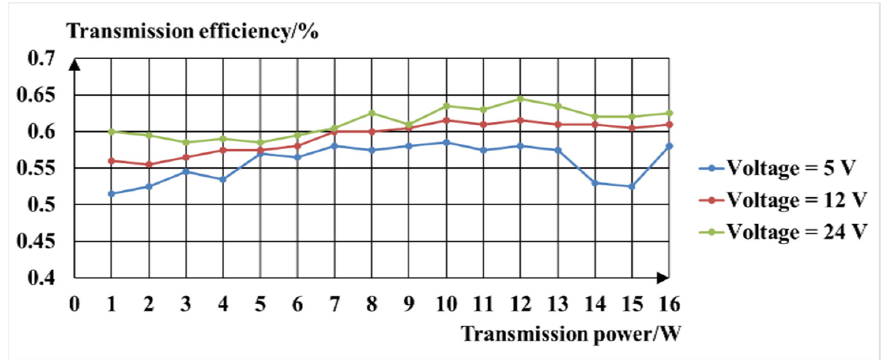
Figure 9. The relationship between transmission efficiency and transmission